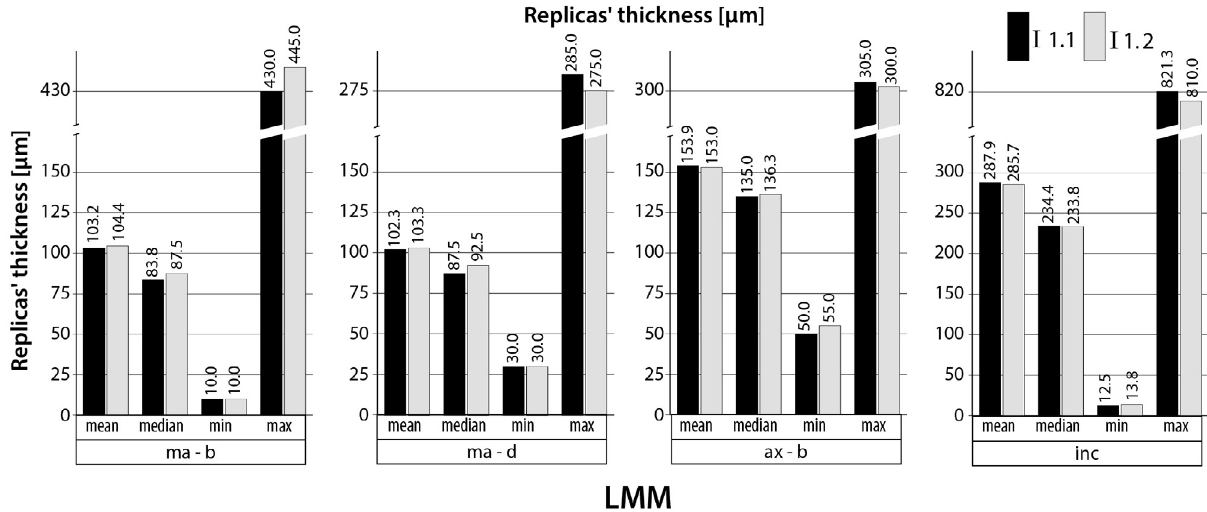
Figure 3- Replicas’ thickness (n=80) for the light microscopy measurements (LMMs); I1.1 and I1.2= first and second measurements of the first investigator (LMM); Measurement points: marginal-buccal (ma-b), marginal-distal (ma-d), axial-buccal (ax-b), incisal